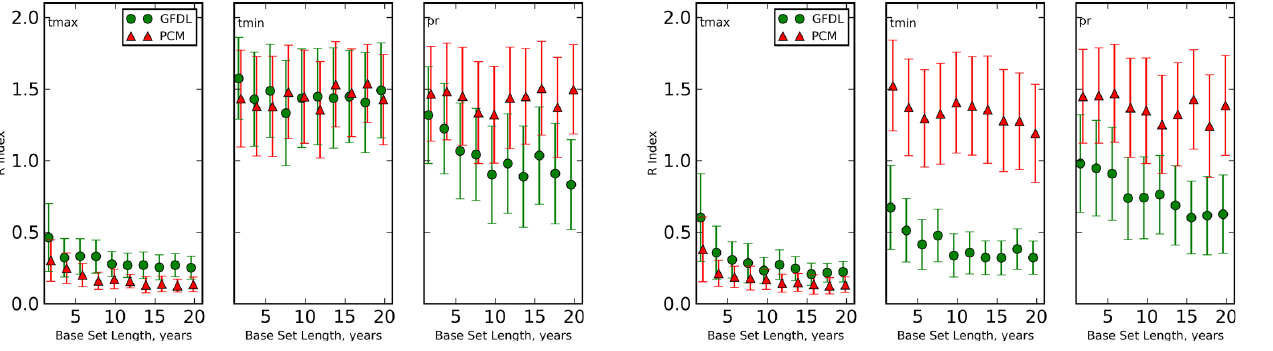
Fig. 11. Similar to Fig. 9, but using an extended observational base period and GCM output.